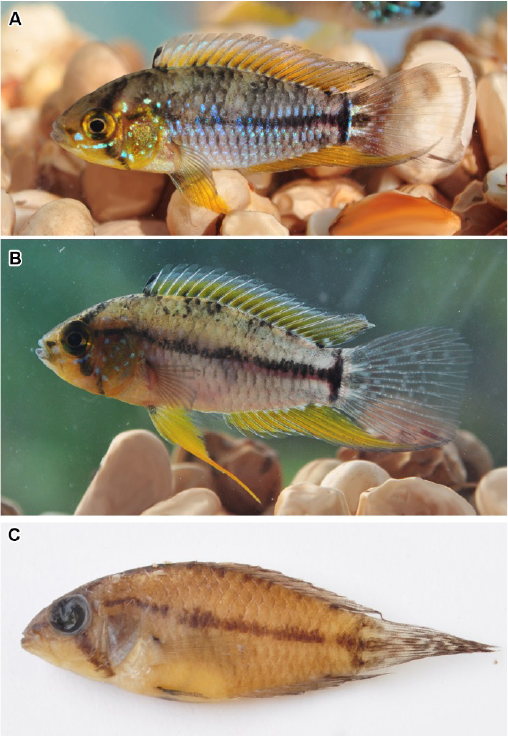
Figure 1. Examples of Apistogrammoides pucallpaensis